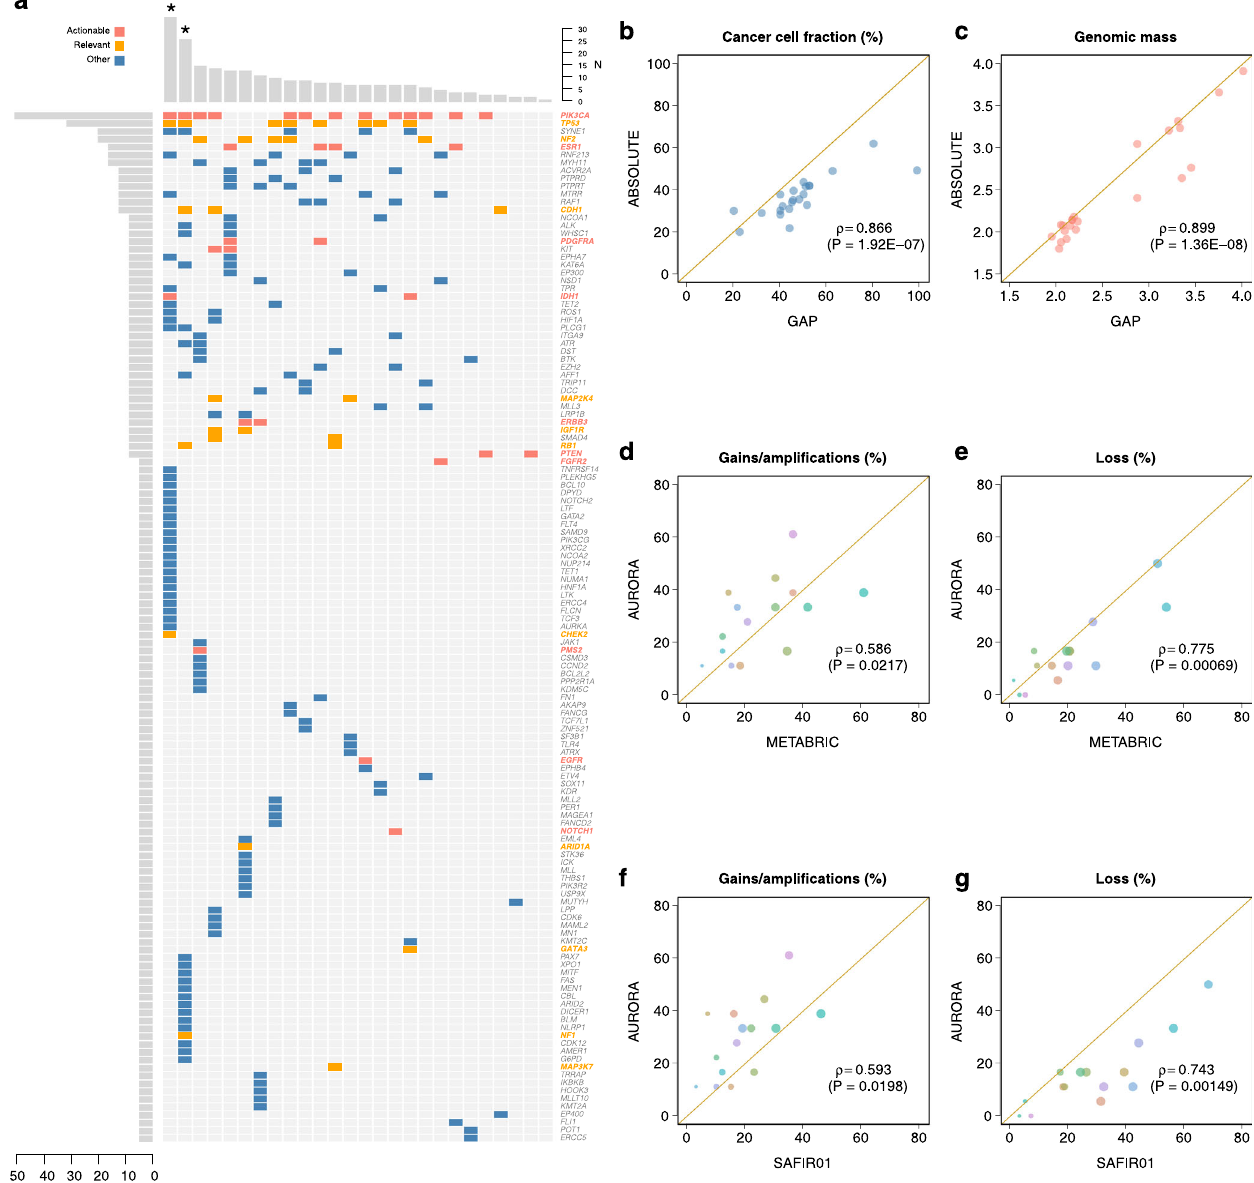
Fig. 2 Mutation detection from the OncoDEEP clinical cancer panel and CNA from SNP arrays. a genes for which at least one mutation was indexed across the 26 patients, b and c comparison of cancer cell fraction and genomic mass respectively obtained from two widely used algorithms for estimating CNA from SNP arrays. In a , asterisk indicates potentially hypermutated patients. In b and c , each dot represents a sample. In d – g , each dot represents a gene from the list of clinically actionable or biologically relevant targets and is the mean of 100 bootstrap replicates such that for each replicate, the external cohorts are matched for ER and HER2 status. The size of each dot is proportional to the standard error of the mean frequency bimodal for the Ion Torrent platform with 5 (29%) samples NGS. Fig. 4a – c show the Log 2 ratios from the SNP array and both displaying a poor correlation of ρ < 0.5 (Fig. 5a). The median NGS platforms for a case patient. The segmented Log 2 ratios from correlation coef fi cients were ρ = 0.615 and ρ = 0.745 for the Ion the SNP array and Illumina sequencing clustered, as expected, into Torrent and Illumina NGS platforms respectively. canonical copy number genotypes whilst the segmented Log 2 In order to further evaluate the ability of both NGS platforms to ratios obtained from the Ion Torrent NGS platform were spread call CNA, the segmented Log 2 ratios were grouped into three between those canonical genotypes leading to relatively poor correlation in Log 2 ratio data space (Fig. 4d and e). Nonetheless, categories i.e. deletion ( − 1), copy neutral (0), gain/ampli fi cation (1) this approach was applied to each copy number platform for 14 and further compared using the accuracy which is the sum of (54%) patients for whom all three data types were available and concordant calls relative to the total number of aberrations. Fig. 5b the segmented Log 2 ratios were compared genome-wide using shows the distribution of accuracy values evaluated genome-wide for each patient. The average accuracy of CNA call was 59.1% for the Spearman ’ s correlation. The distribution of correlation the Ion Torrent and 74.0% for the Illumina NGS platforms. Both coef fi cients comparing the SNP array to the NGS data was